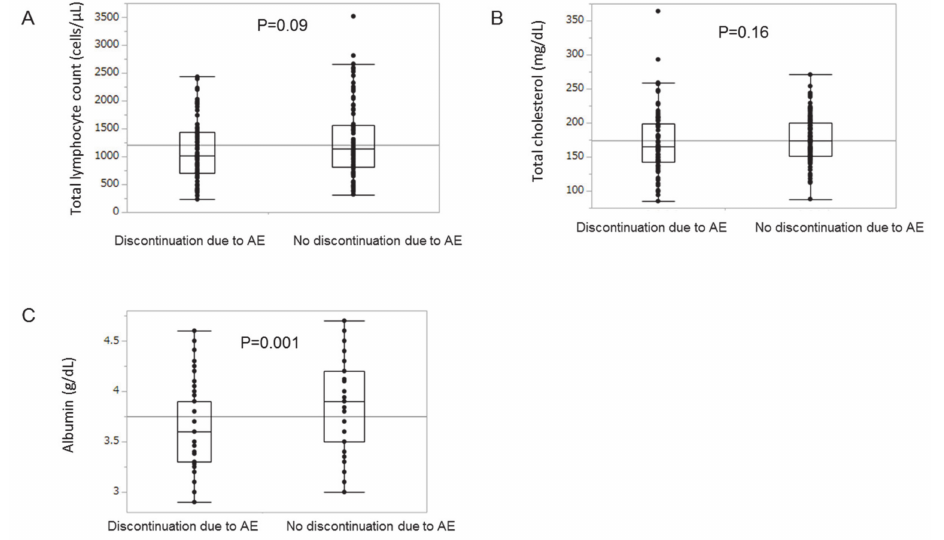
Figure A3. The di ff erence in the parameters of the CONUT score between the discontinuation and no discontinuation of LEN due to AE (adverse events). (a) total lymphocyte count, (b) total cholesterol level, and (c) serum albumin